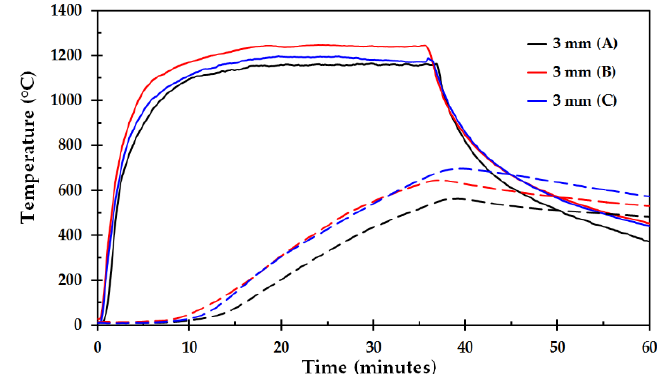
Figure 4. Temperature as a function of time for a representative test (6 mm thick steel plate thickness). Temperatures of the exposed and backing steel plates are marked E and B, respectively. The numbers indicate the radial thermocouple position (in mm). PT represents the plate thermometer.